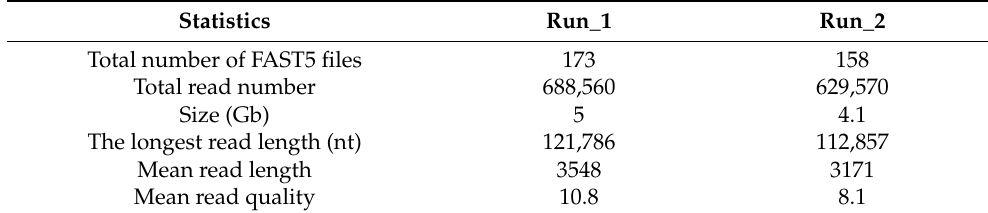
Table 1. Statistics results compiled by NanoPlot for raw FASTQ files generated by the two nanopore sequencing